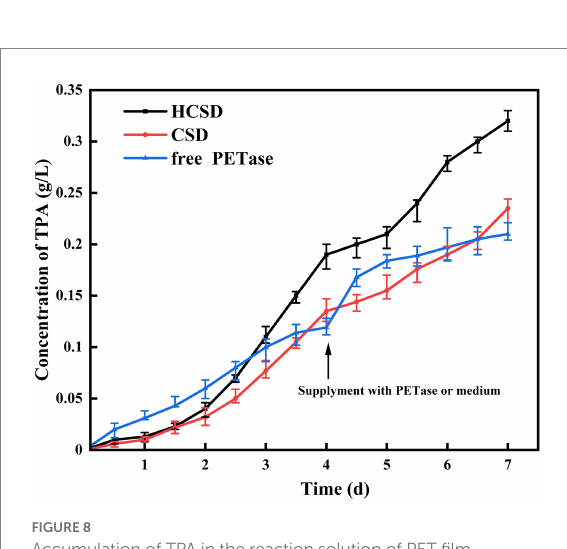
FIGURE 8 Accumulation of TPA in the reaction solution of PET film degradation at different degradation time. On the fourth day, 30 ml LB medium was supplied to the degradation system of HCSD and CSD, and unpurified crude PETase from 30 ml of cell culture was added to the degradation system of free PETase at the same